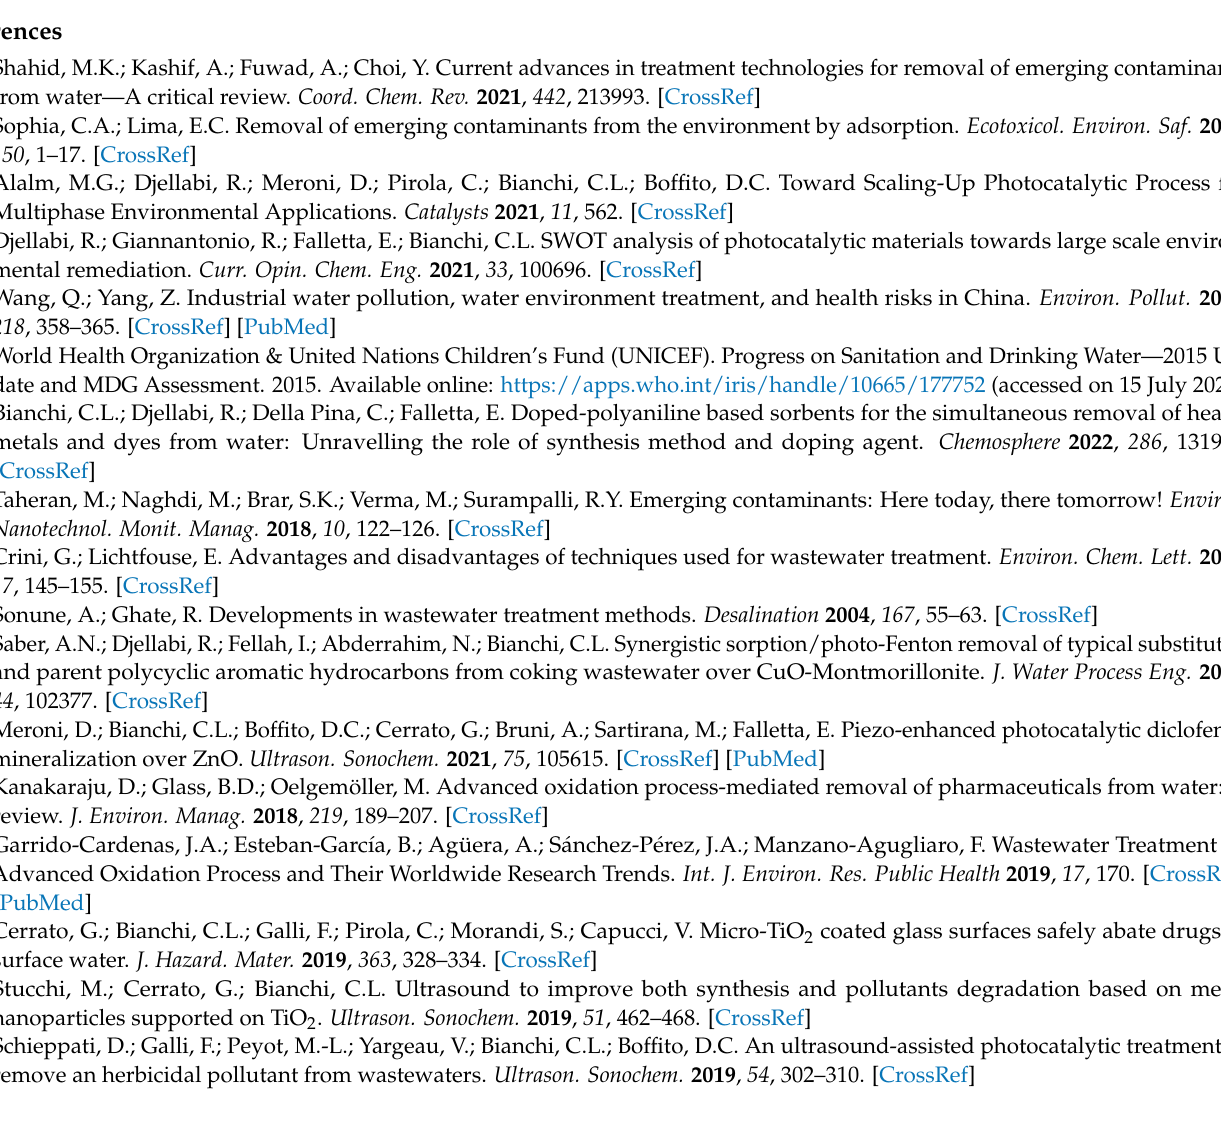
Figure S4: Photolysis study for DCF decomposition without any catalyst; Figure S5: Percentage of DCF mineralization by STOm and STOn in UW; Figure S6: FT-IR spectra and XRPD pattern of used